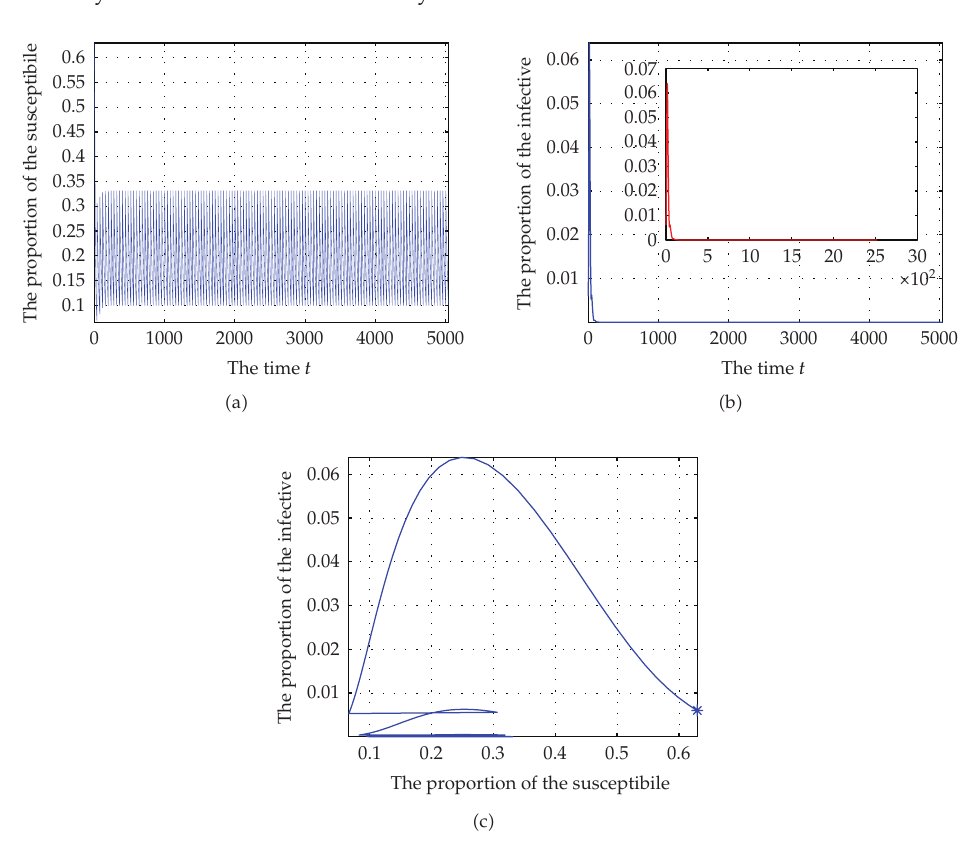
Figure 1: The time series and the orbits of the system (cid:5) 2.4 (cid:6) with R ∗ < 1. (cid:5) a (cid:6) and (cid:5) b (cid:6) show the time series for susceptible and infective, respectively. (cid:5) c (cid:6) shows the orbits s − i plane.